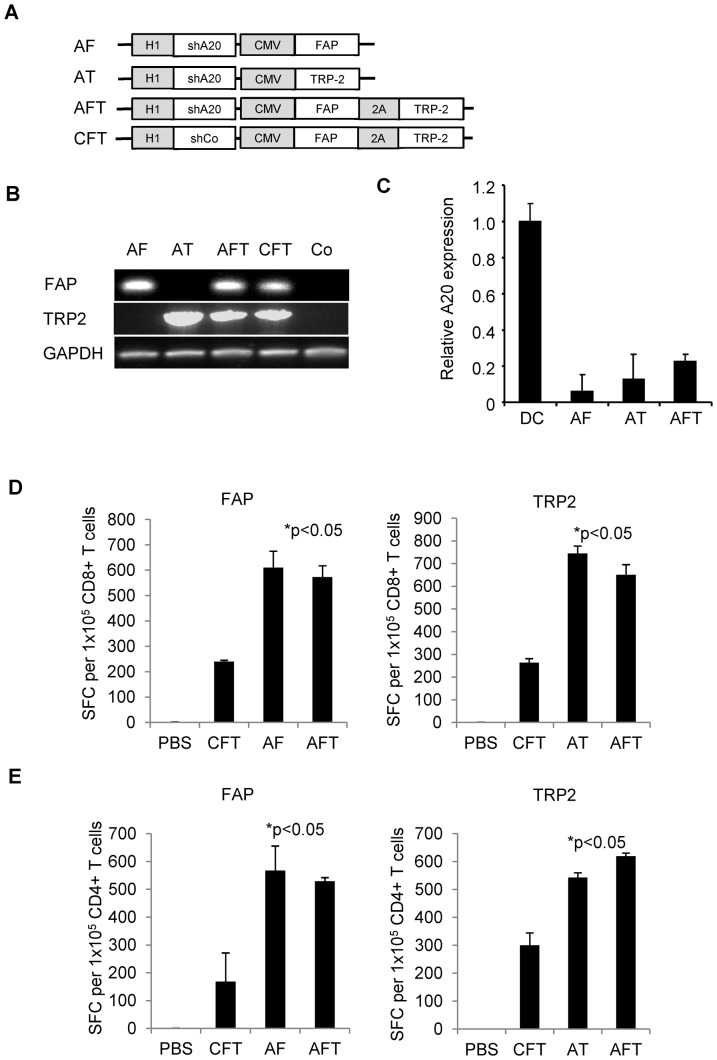
Tumor- and FAP- co-targeted DC induce T-cell activation.(A) Scheme of lentiviral constructs. (B and C) Mouse BM-DCs were transduced with lentivirus and FAP and TRP2 expression (B) and A20 expression (C) were detected by RT-PCR or Q-PCR individually. (D and E) Mice were immunized with 1×106 lentivirus-transduced BM-DCs in 25 µl sterile PBS or PBS control through footpad 14 days post vaccination splenocytes were prepared and CD8+ (D) and CD4+ (E) T cells selected. The frequency of FAP- and TRP2-specific T cells was determined using IFN-γ ELISPOT assays (n = 2; assay performed in triplicates). AF, lentiviral vector coexpressing an A20-specific short-hairpin RNA (shRNA) and FAP; AT, lentiviral vector coexpressing A20-shRNA and TRP2; AFT, lentiviral vector coexpressing A20-shRNA, FAP, and TRP2; CFT, lentiviral vector coexpressing GFP-shRNA, FAP, and TRP2; GAPDH, glyceraldehyde 3-phosphate dehydrogenase; PBS, phosphate-buffered saline.